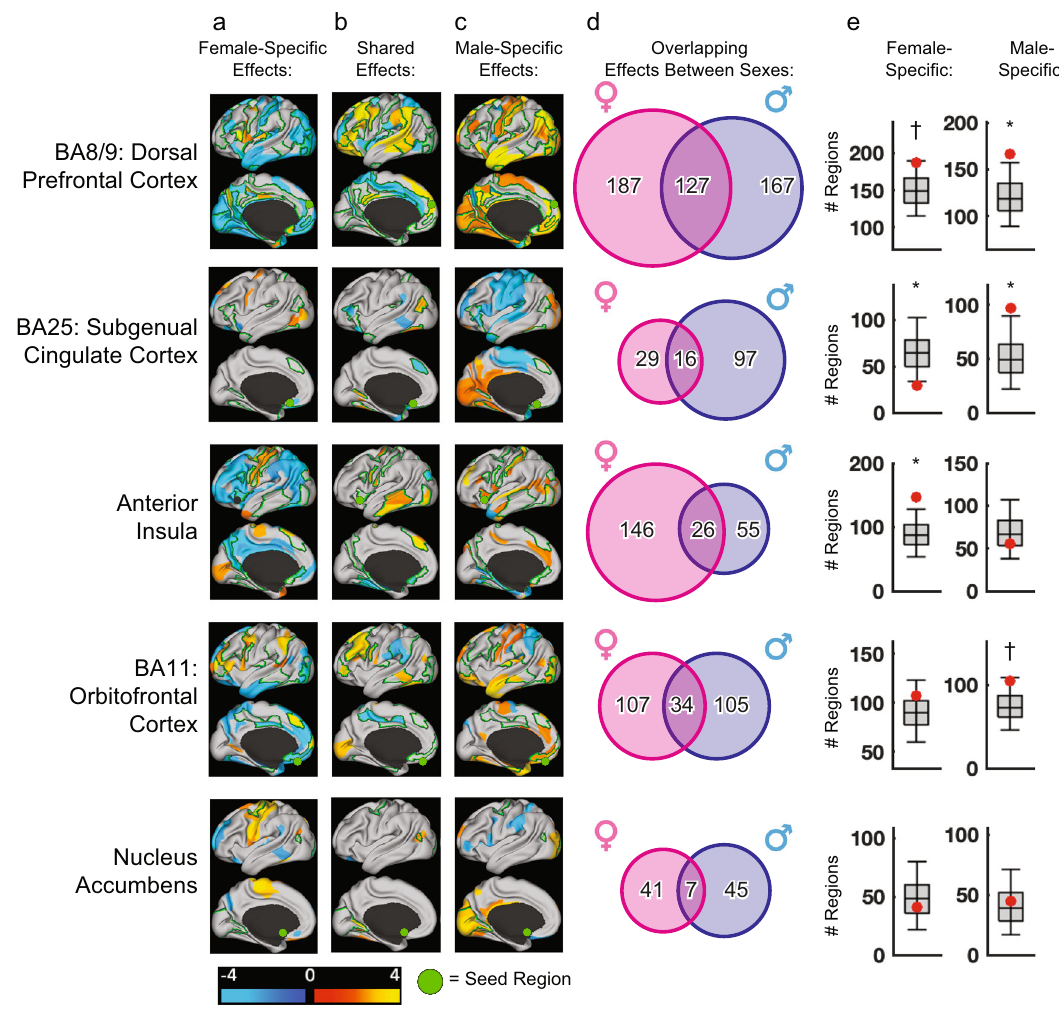
Fig. 3 | Sex-speci fi c rsFC changes in fi ve transcriptomic regions of interest. a – c Color maps of depressed vs healthy t-statistics showing the neuro-anatomical distribution of rsFC abnormalities that are ( a ) female-speci fi c, b shared between sexes, or ( c ) male-speci fi c in fi ve transcriptomic seed ROIs labeled in rows, depicting the peak t-statistic across both hemispheres for each functional parcel. Parcels with signi fi cant (FDR q <0.05) main effects of MDD or MDD-by-sex inter- actions are outlined in green and presented in detail in Supplementary Fig. S4. To illustrate how sex-speci fi city is not driven by stringent thresholding, we also plot